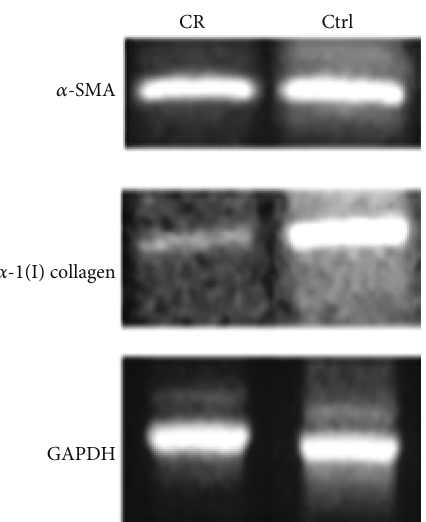
Figure 3: RT-PCR of profibrogenic proteins. Gene expressions of 𝛼 -Smooth Muscle Actin ( 𝛼 -SMA, product size = 446 bp) and 𝛼 - 1(I) collagen (product size = 174 bp). The house keeping gene, glyc- eraldehyde-3-phosphate dehydrogenase (GAPDH, product size = 346 bp)wasusedtoestablishequalloading.Thecaloricallyrestricted (CR) mice ( 𝑁 = 7 ) has decreased expression of 𝛼 -1(I) collagen as compared with mice fed ad libitum (Ctrl, 𝑁 = 7